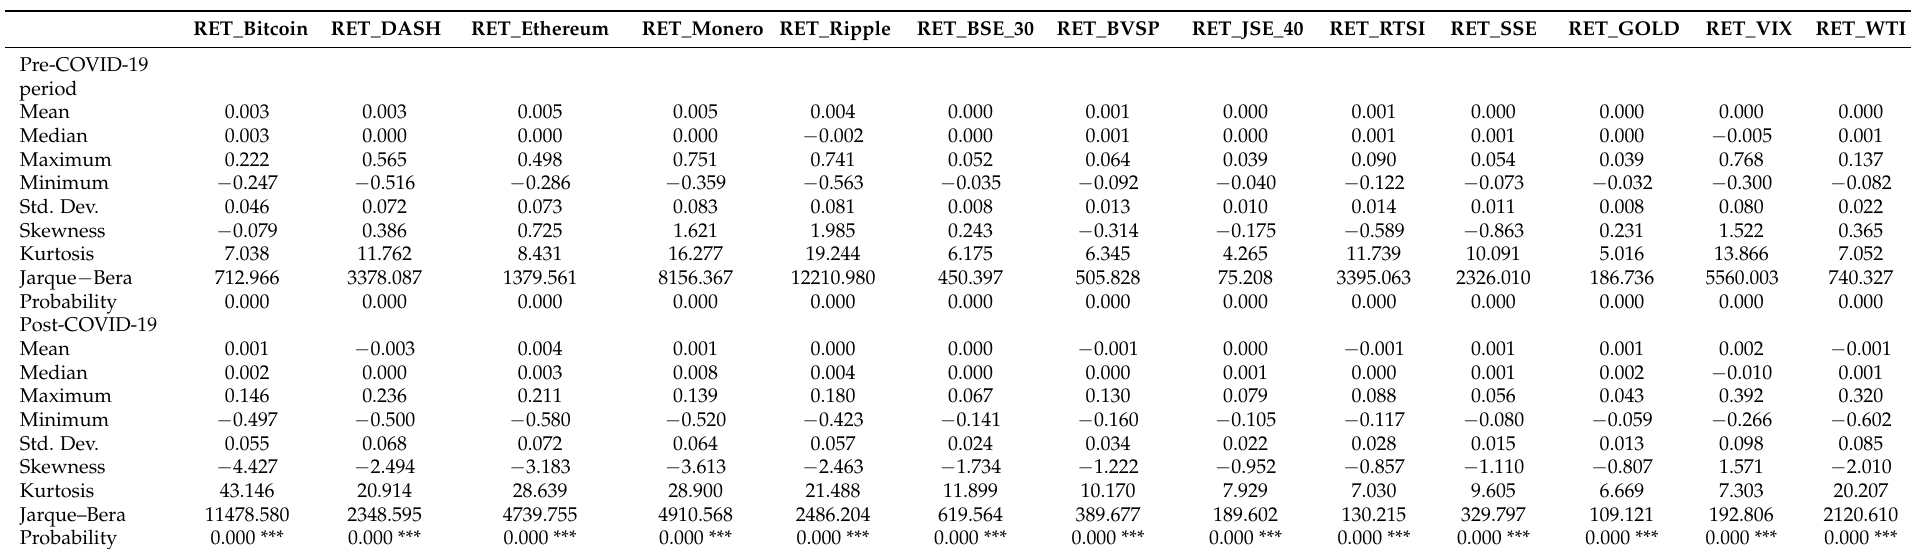
Table 1. Stochastic properties of return series